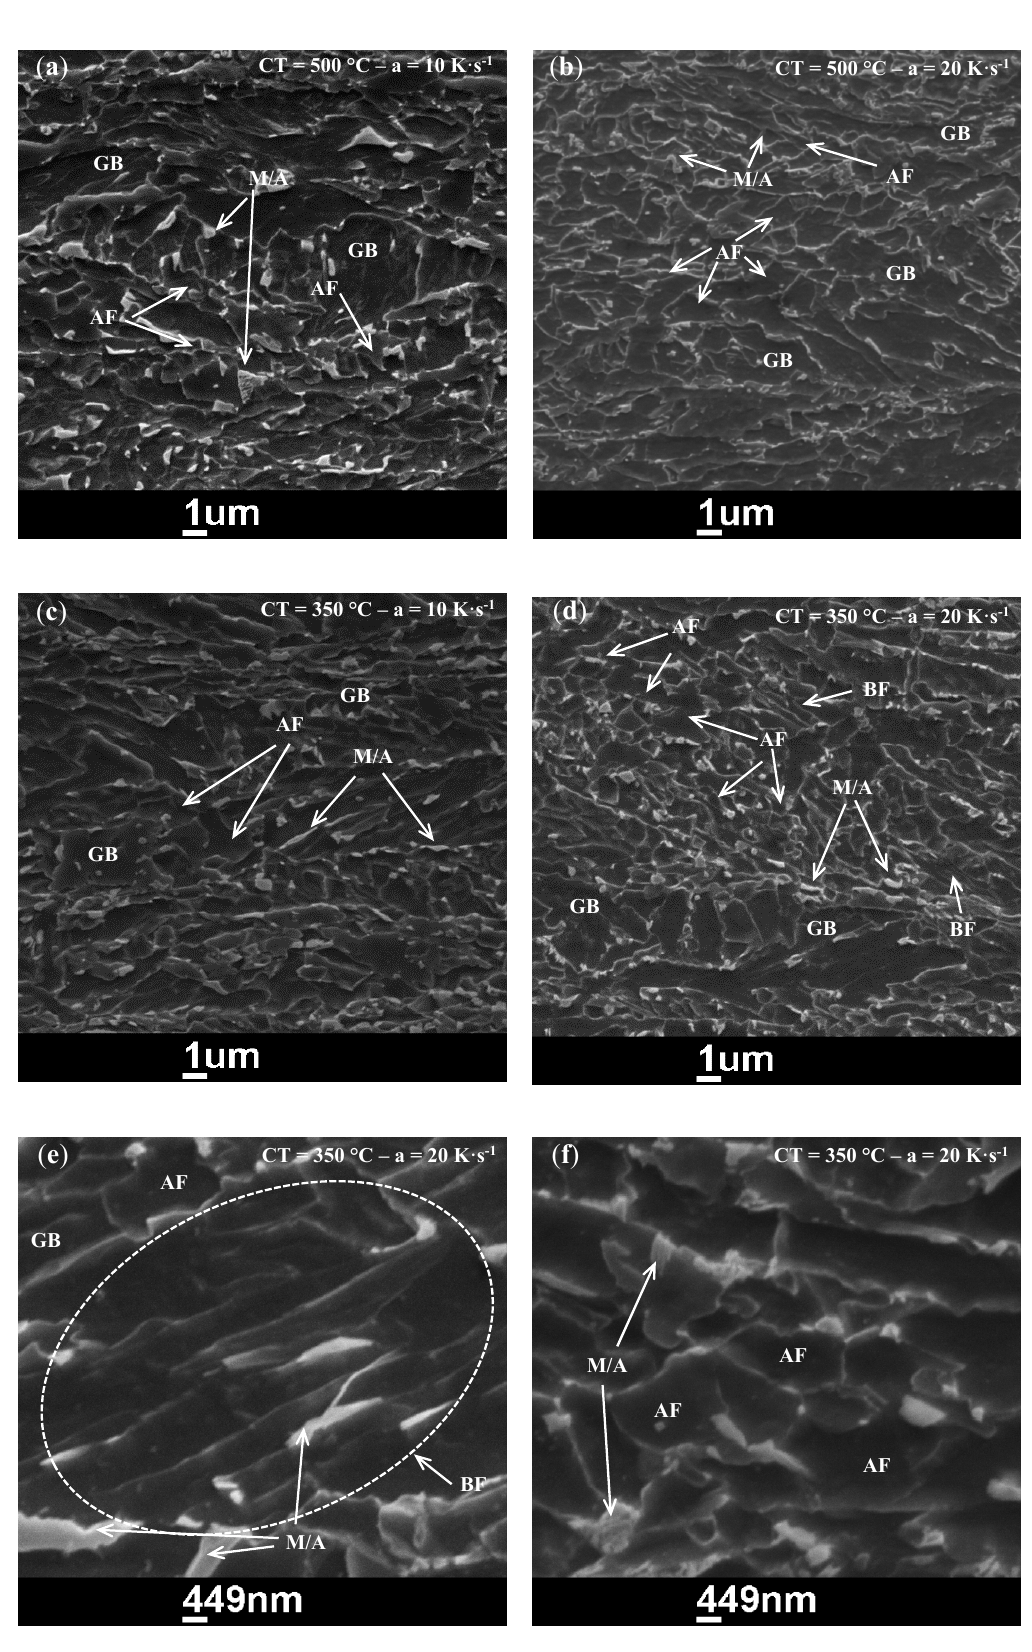
Figure 7. Scanning electron micrographs of samples processed under the prescribed conditions and having FRT = 780 ◦ C. ( a , b ) for CT = 500 ◦ C, ( c , d ) for CT = 350 ◦ C and ( e , f ) higher magnification images of structure with same processing conditions as that of ( d